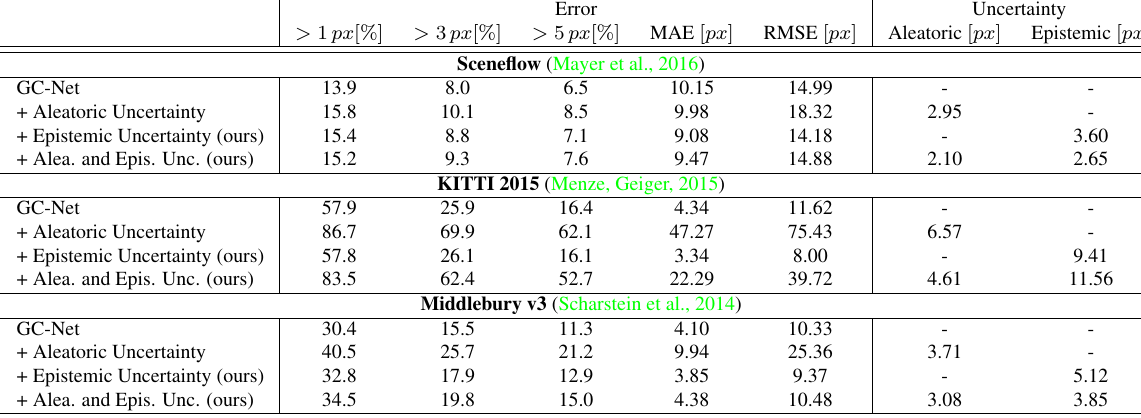
Table 1: Quantitative results on the three evaluated datasets. From the Sceneflow and the KITTI dataset, 100 random image pairs and from the Middlebury dataset, all 15 training pairs are used for evaluation. The results are compared against the original GC-Net architecture (Kendall et al., 2017) and a modified variant which allows to estimate aleatoric uncertainty (Kendall, 2017). GC-Net (Kendall et al., 2017) and a variant which additionally